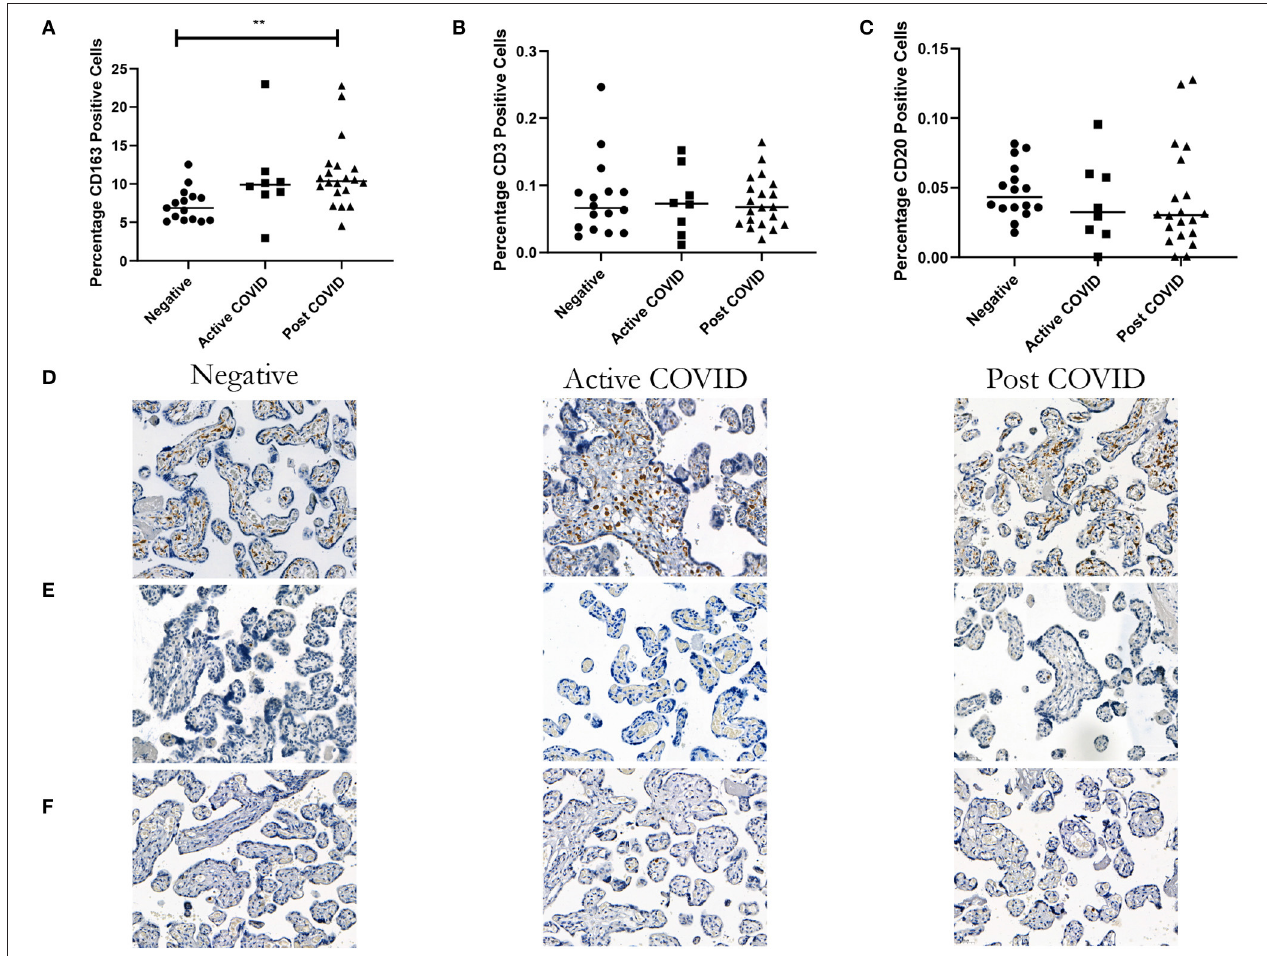
FIGURE 1 | Increase in the percentage of macrophages in placentas from women who tested positive for COVID-19, but no difference in the percentage of T or B cells. (A) A significant increase in the percentage of CD163 macrophages in the Active and Post-COVID groups compared to negative controls. (B) No difference in the percentage of CD3 cells between groups. (C) No difference in the percentage of CD20 cells between groups. Representative images, magnification X20 (D) CD163, (E) CD3, (F) CD20. Kruskal-Wallis, ** p < 0.009. Active COVID n = 8, Post COVID n = 20, and controls n =